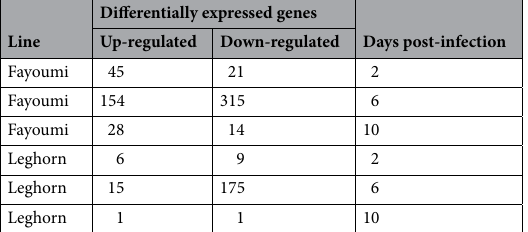
Table 1. Numbers of differentially expressed genes that were up-regulated and down-regulated between treated and non-treated groups by genetic line and time post-infection.